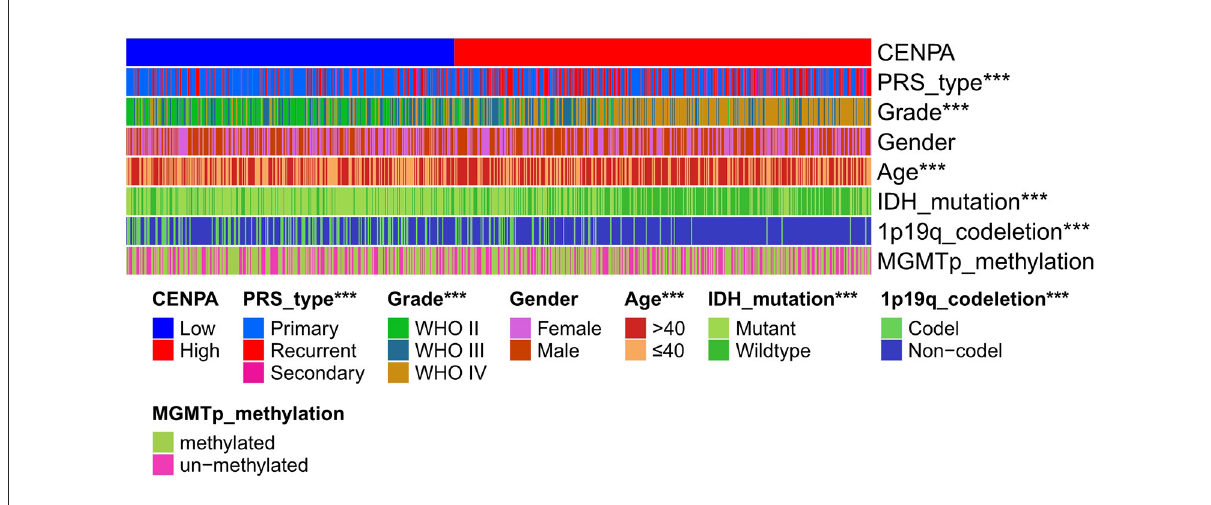
FIGURE4 Heatmap of clinical pathological characteristics in high- and low-CENPA expression groups (chi-square test, * P < 0.05, ** P < 0.01, *** P < 0.001).